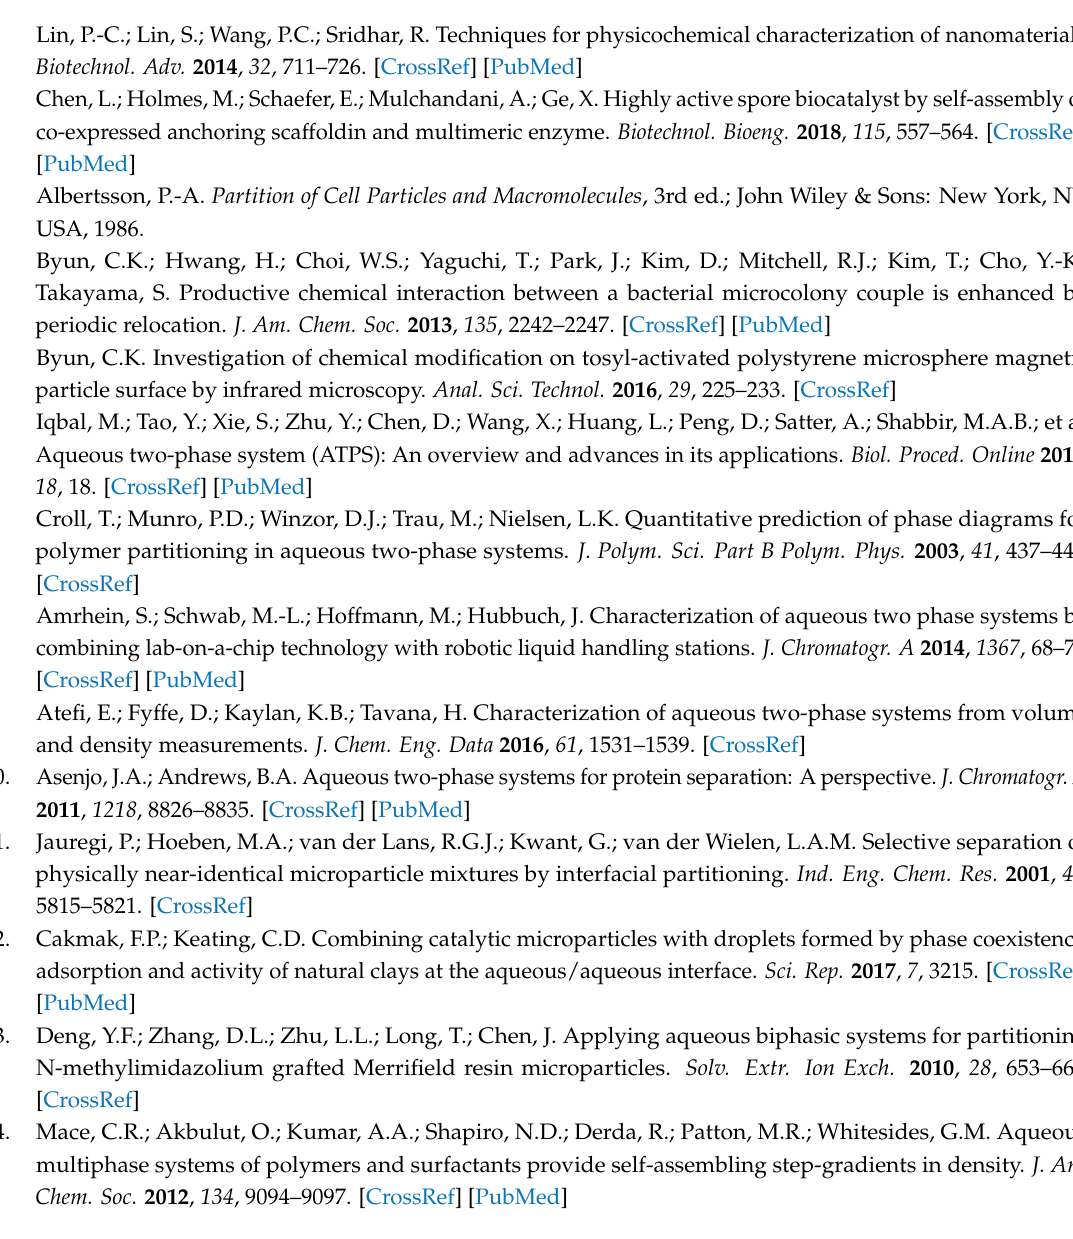
Figure S1. Infrared spectra of (a) PS microparticle (blue), DEX-modified particle (red), and amino-dextran (green); (b) PS microparticle (blue), PEG-modified particle (red), and methoxy-PEG-amine (green); (c) PS microparticle (blue), BSA-modified particle (red), and BSA (green); see reference [5] for peak assignments and